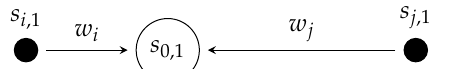
Figure 7. A simplication to estimate z ( s 0 ) based on z ( s i ) and z ( s j ) with linear interpolation for d =